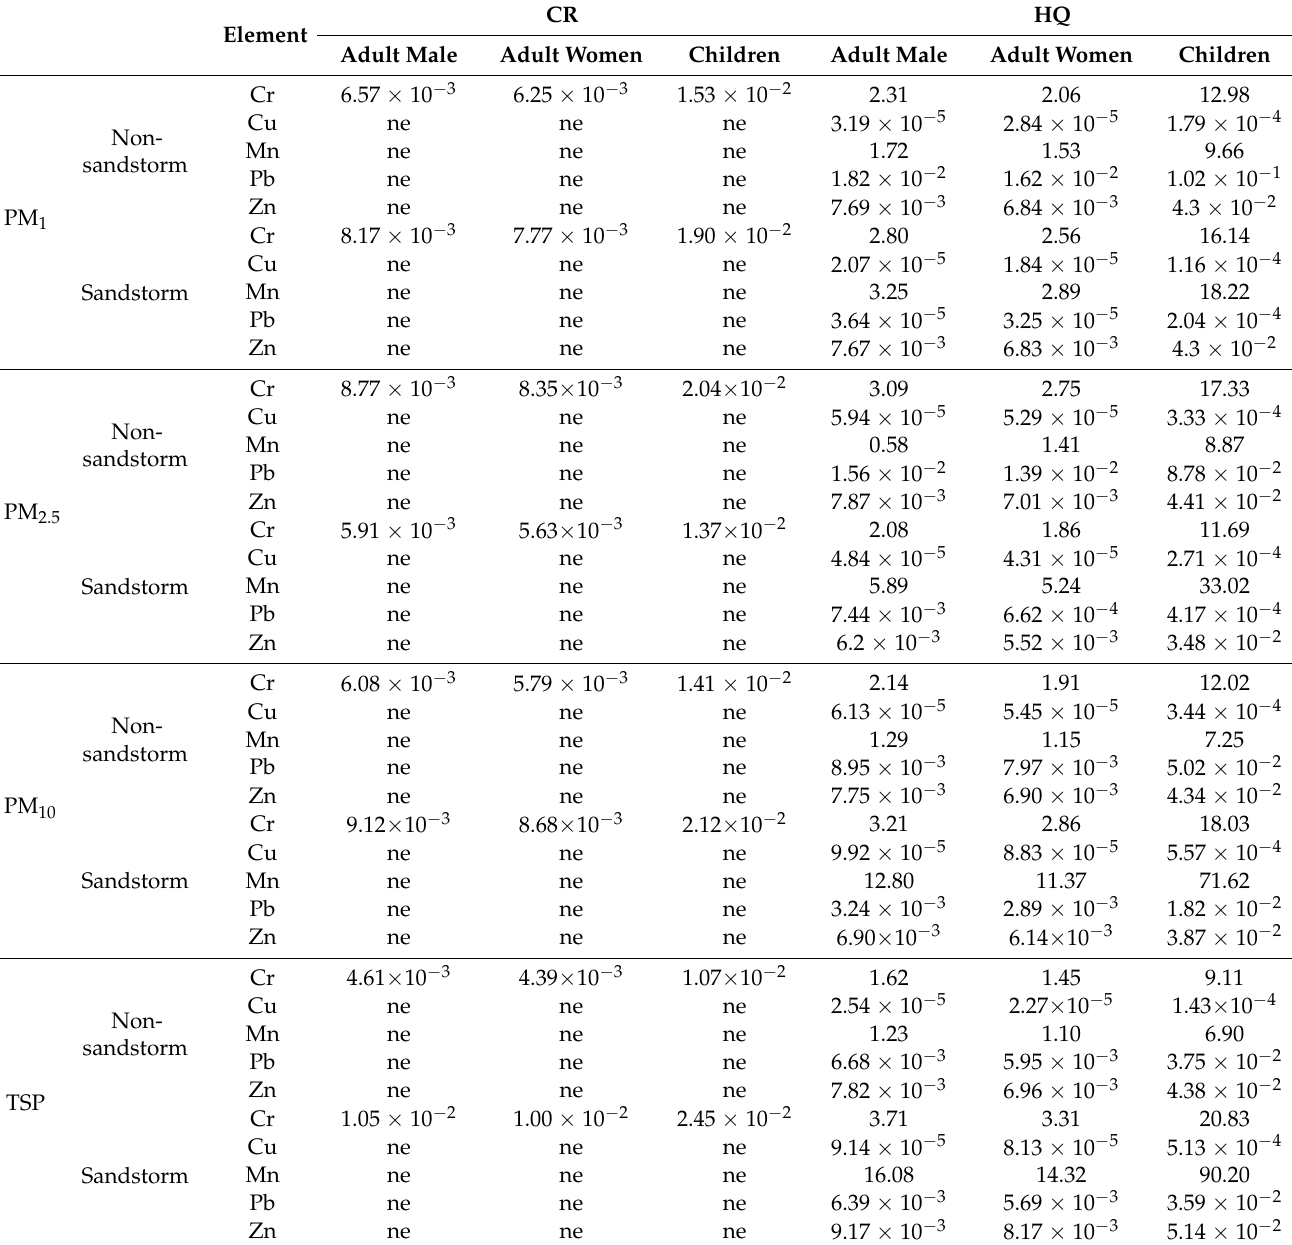
Table 1. Healthriskassessmentoftoxicmetalelementsinatmosphericparticulatestodifferentpopulations. Element